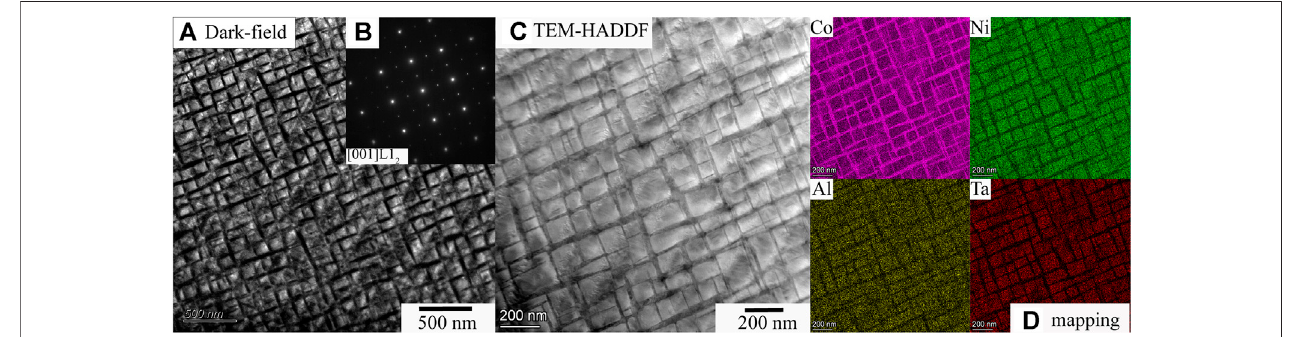
FIGURE 3 | (A) Room-temperature hardness and γ ′ area fraction of Co-30Ni-10Al-6Ta (at%) alloy annealed at 800 ° C for different times, (B) XRD images, and (C) DSC curve of Co-30Ni-10Al-6Ta (at%) alloy annealed at 800 ° C for 48 h. (D) Comparison of alloy characteristics between the experimental and calculated results.